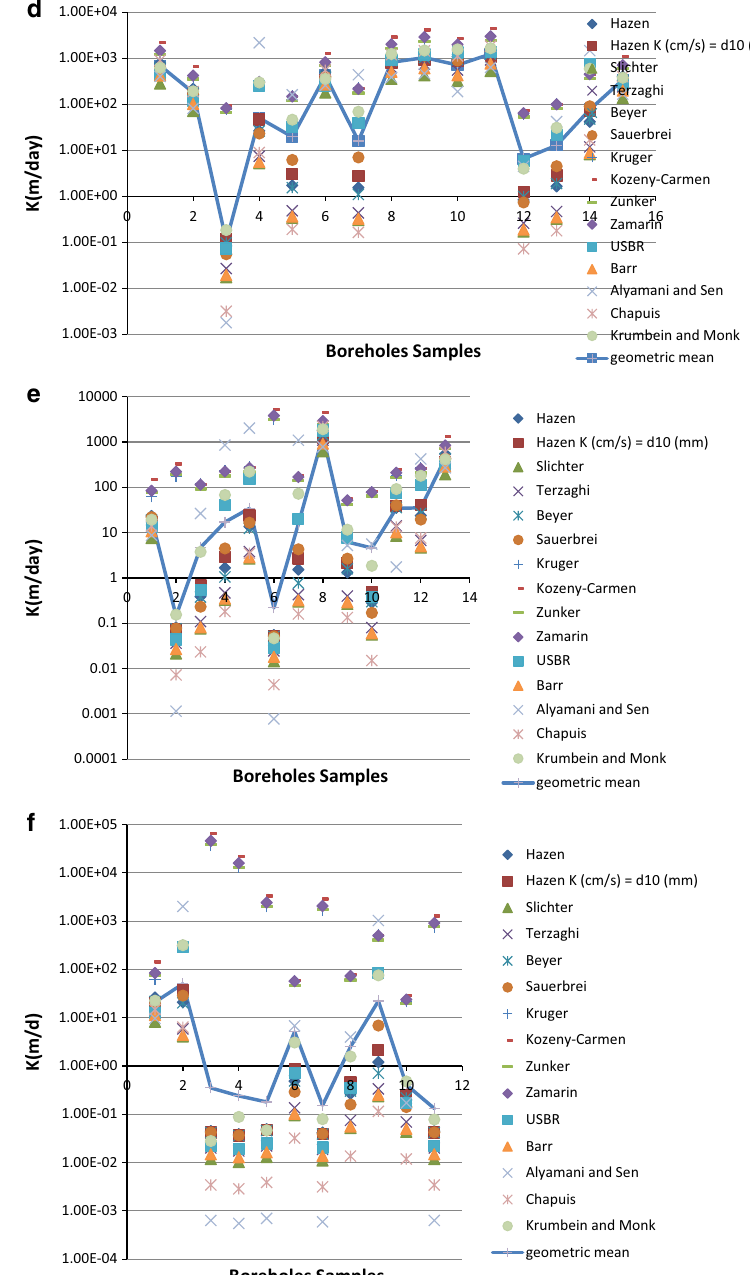
sand (Table 8). Comparison between the results of the fall- ing head permeability test and the values obtained from pumping tests was then made. Both tests exhibited similar trends with the measured permeability decreasing along with depth. Pumping test exhibited a coefficient of permeability that was slightly higher than the values obtained from the falling head test. On the other hand, the permeability values obtained from pumping tests compare well with the values measured from the falling head test. This highlighted the fact that the permeability of the soil depends on a good aquifer